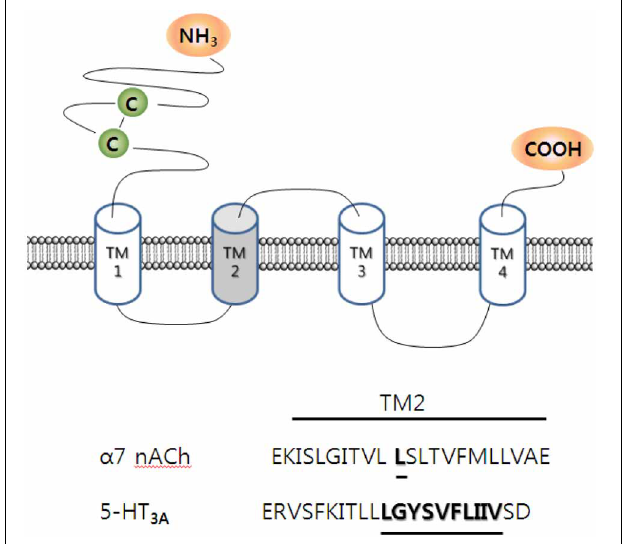
FIGURE 4 | Topology and sequence alignment of α 7 nicotinic acetylcholine (nACh) and 5-HT 3A receptors at transmembrane domain 2 (TM2). α 7nACh and 5-HT 3A receptors consist homomeric pentamer. TM2 of each segment forms a channel pore. The underlined specific amino acid residues in those ligand-gated channels are thought to interact with 20( S )-ginsenoside Rg 3 (Lee et al., 2007,